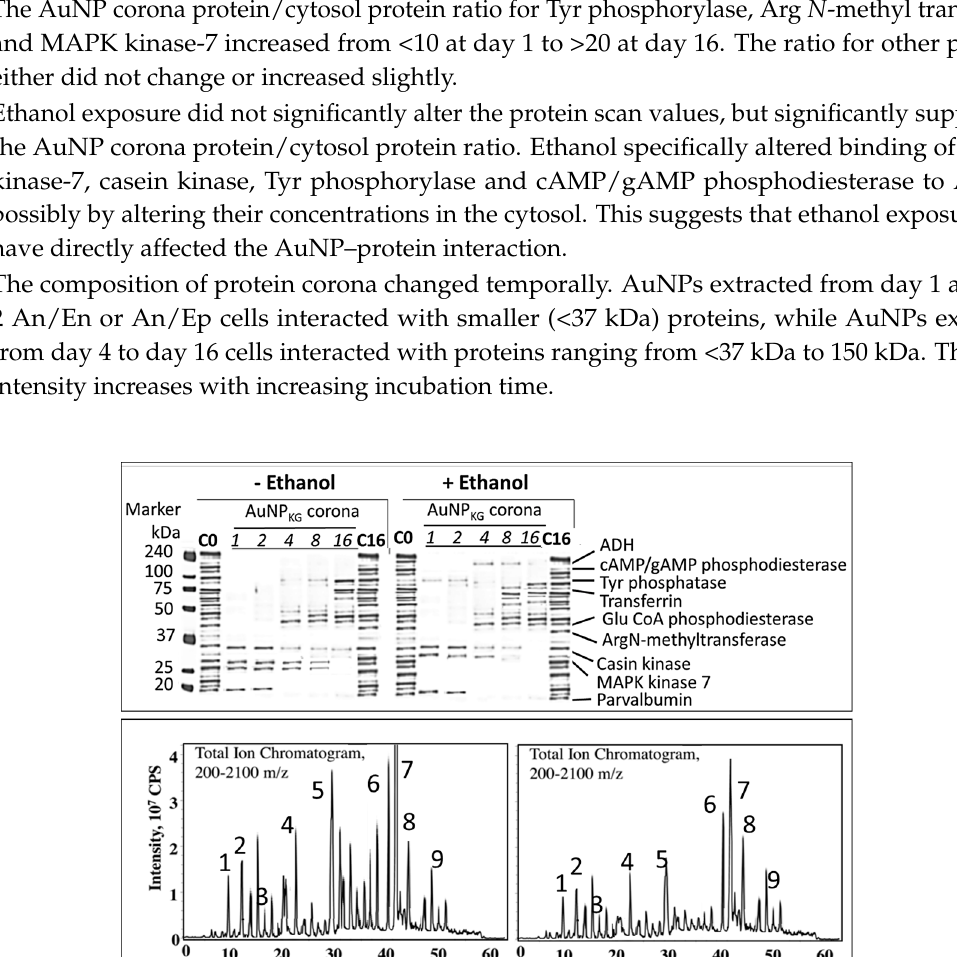
Figure 16. Time course of change in individual protein concentrations in cytosol and desorbed from AuNP KG-50 . Abbreviation: CaK: casein kinase, Tyr: tyrosine, Palb: parvalbumin, UI: unidentified.